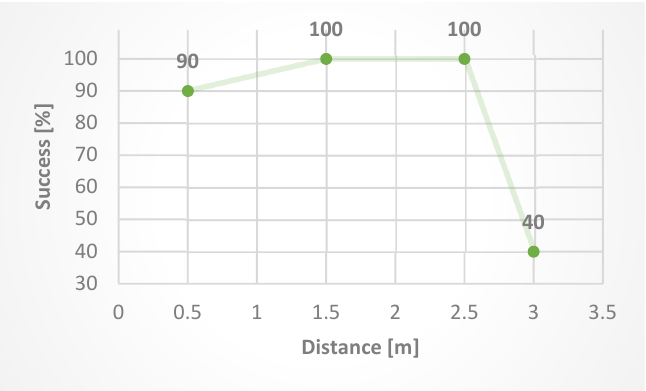
Figure 10. Success of detection at different distances (10 photos at each distance) from the camera for five outstretched fingers.